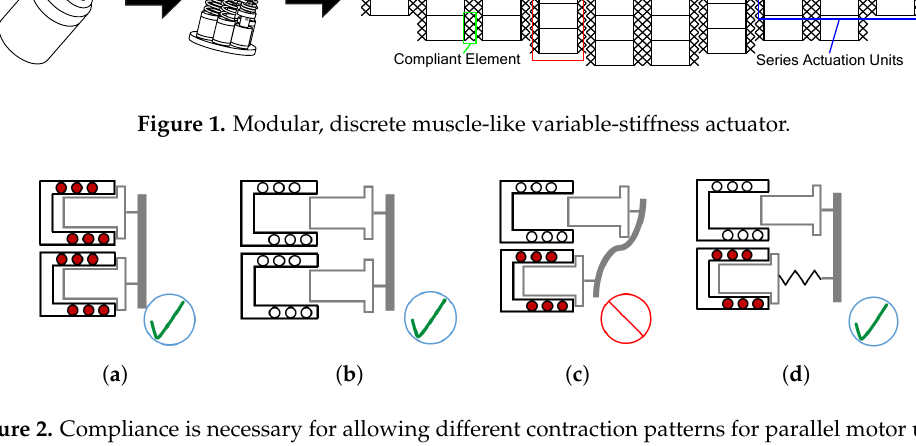
Figure 2. Compliance is necessary for allowing different contraction patterns for parallel motor units. element in the fourth figure: ( a ) rigid connection for active units; ( b ) rigid connection for non-active units; ( c ) breaks laws of mechanics of materials; and ( d ) addition of compliant